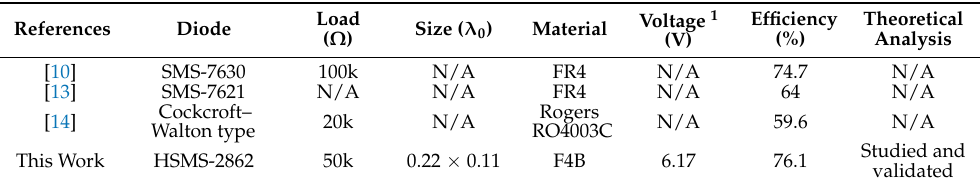
Table 1. Comparison of the proposed PW rectifier with others in the